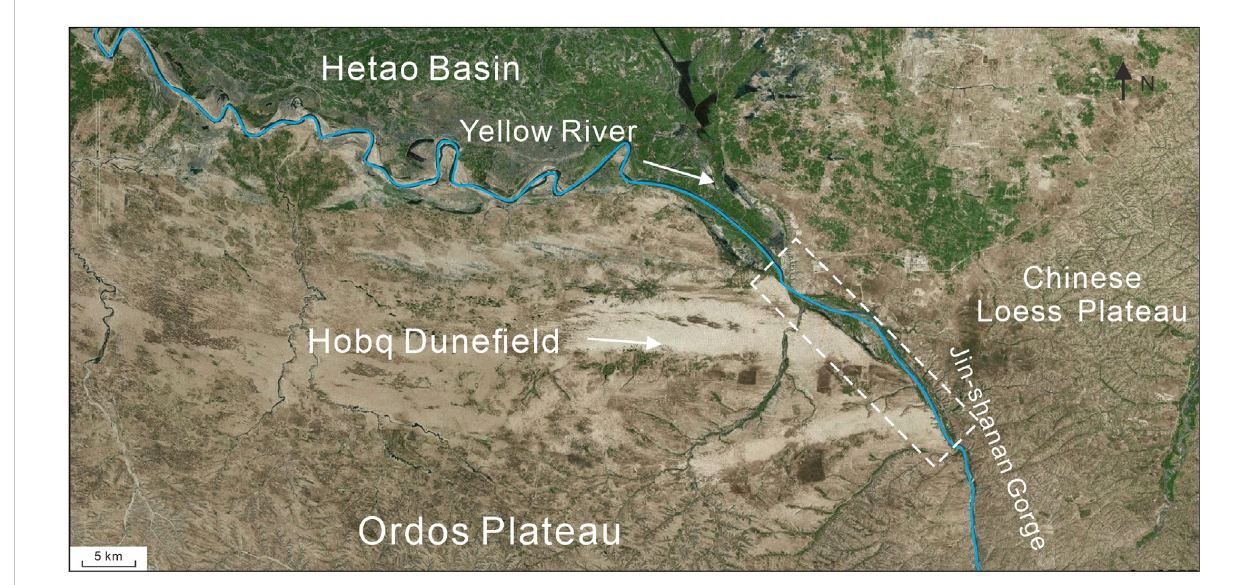
FIGURE 8 Entrance of the Jin-shanan Gorge, where the Yellow River might have been dammed by the Hobq dune fi eld in some narrow places (white